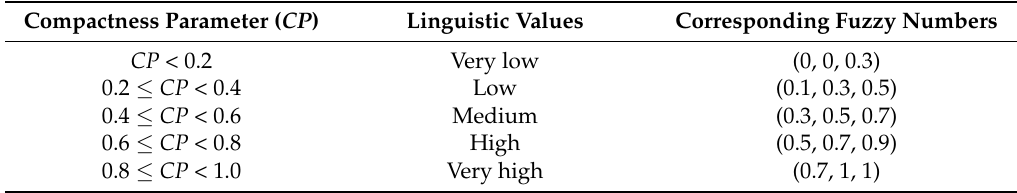
Table 3. Linguistic values and their corresponding fuzzy numbers of compactness.